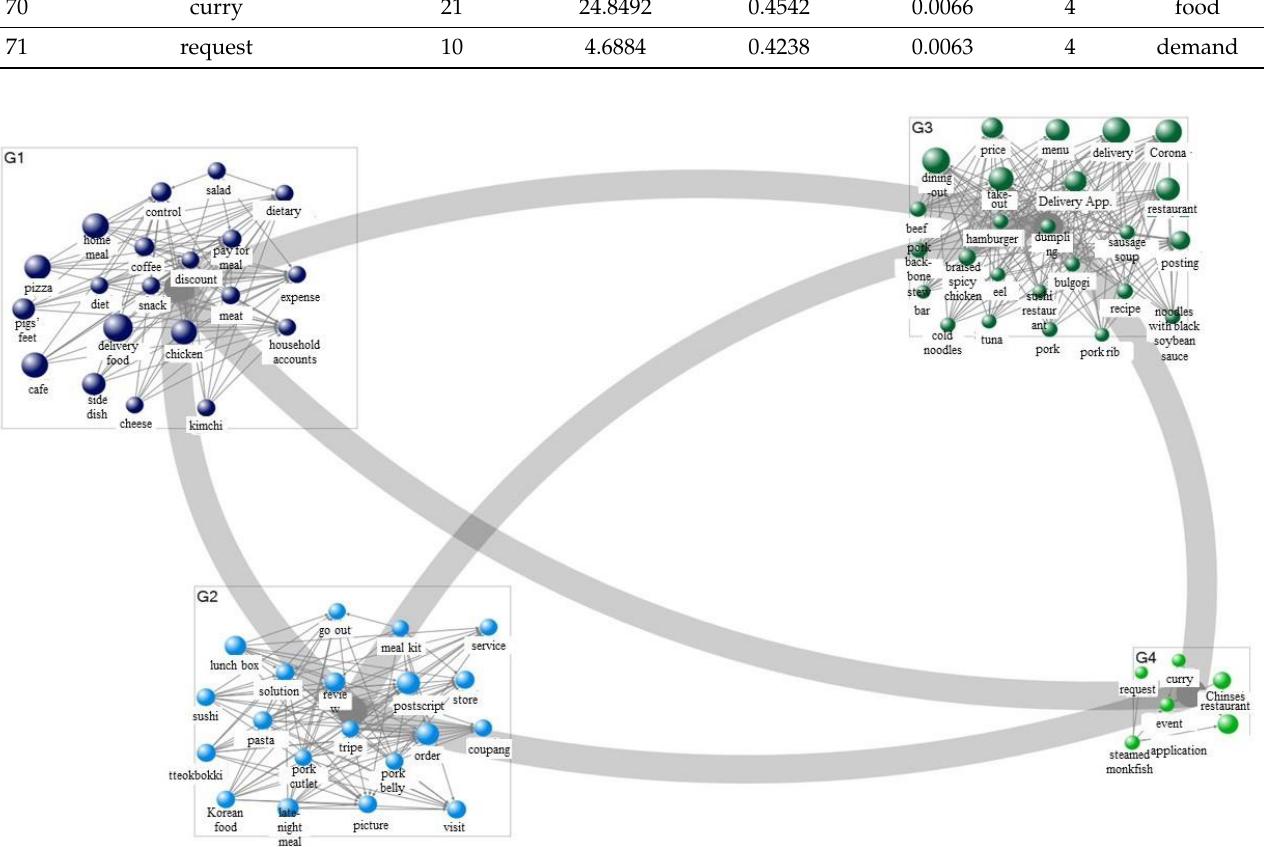
Figure 4. Demand network visualization of food delivery (2021).